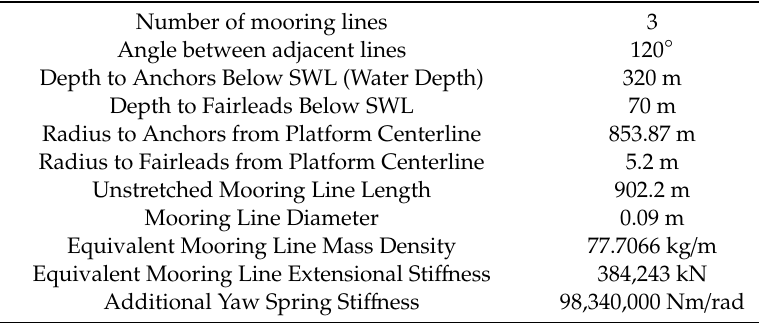
Table 2. OC3-Hywind mooring system specifications